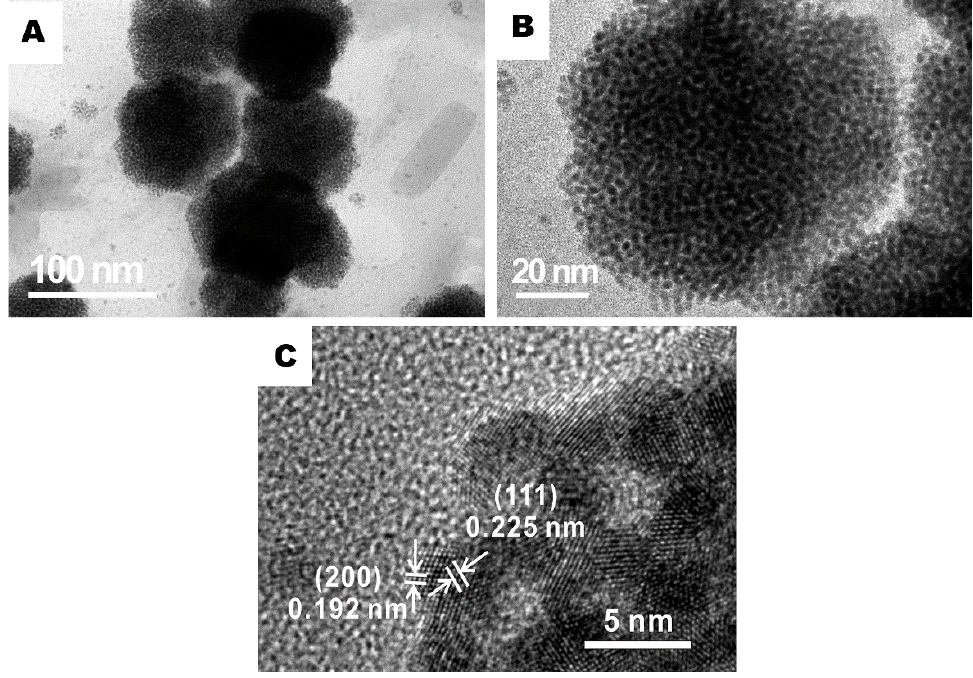
Figure 4. Representative high revolution transmission electron microscope (HRTEM) images of the rGO/PANI@PtNi composite at various magnifications: (a) ×75,000; (b) ×195,000; (c) ×1,000,000